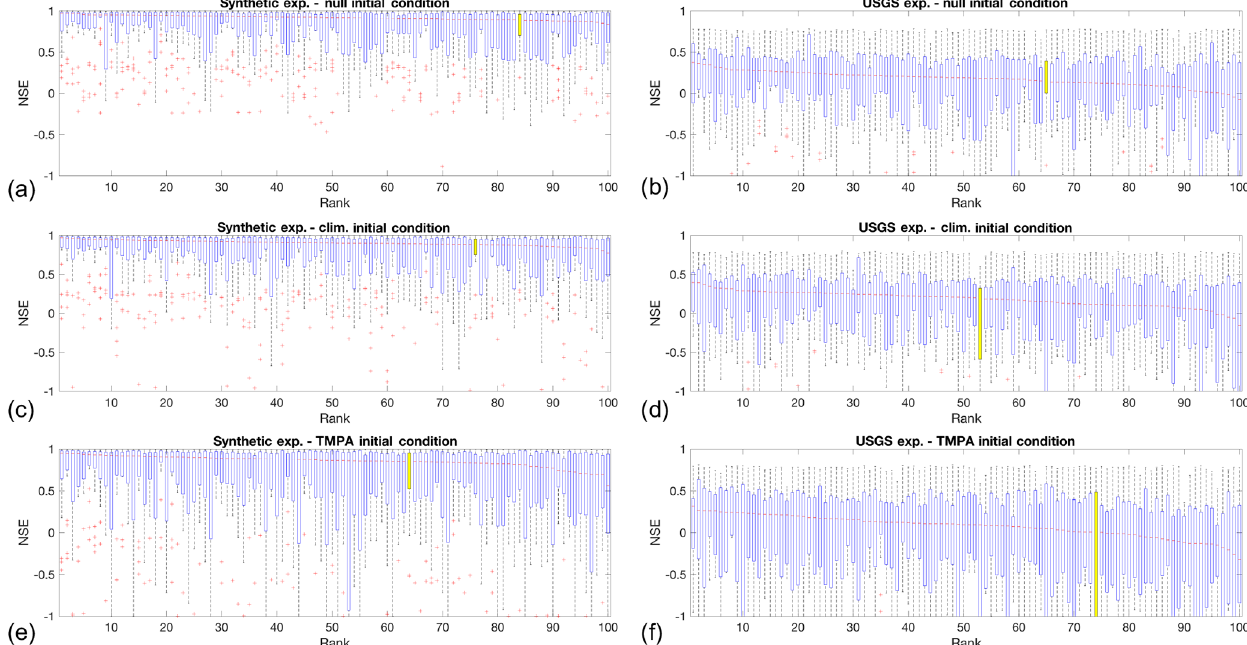
Figure 10. Box plots of NSE values at 25 validation sites for 100 random configurations of the gauge network. Experiments are divided into two categories: the entirely synthetic discharge reconstructions (a, c, e) and the discharge reconstructions from USGS observations (b, d, f) . These experiments are further differentiated by the three initial runoff conditions used: null (a, b) , climatology (c, d) , and TMPA derived (e, f) . The yellow box plots represent the gauge network configuration used for the results presented in this